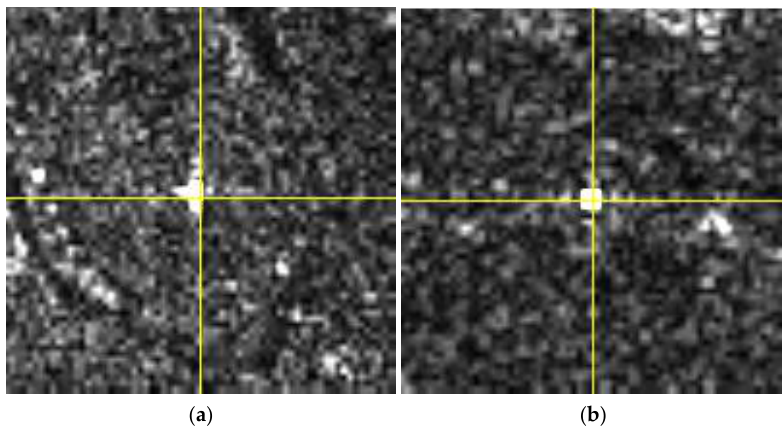
Figure 2. Appearance of the same 1.5 m corner reflector (such as shown in Figure 1a) in two S-1 product image extracts: ( a ) S1-B SM SLC; ( b ) Sentinel-1A (S-1A) IW SLC. The extracts are 70 × 70 samples